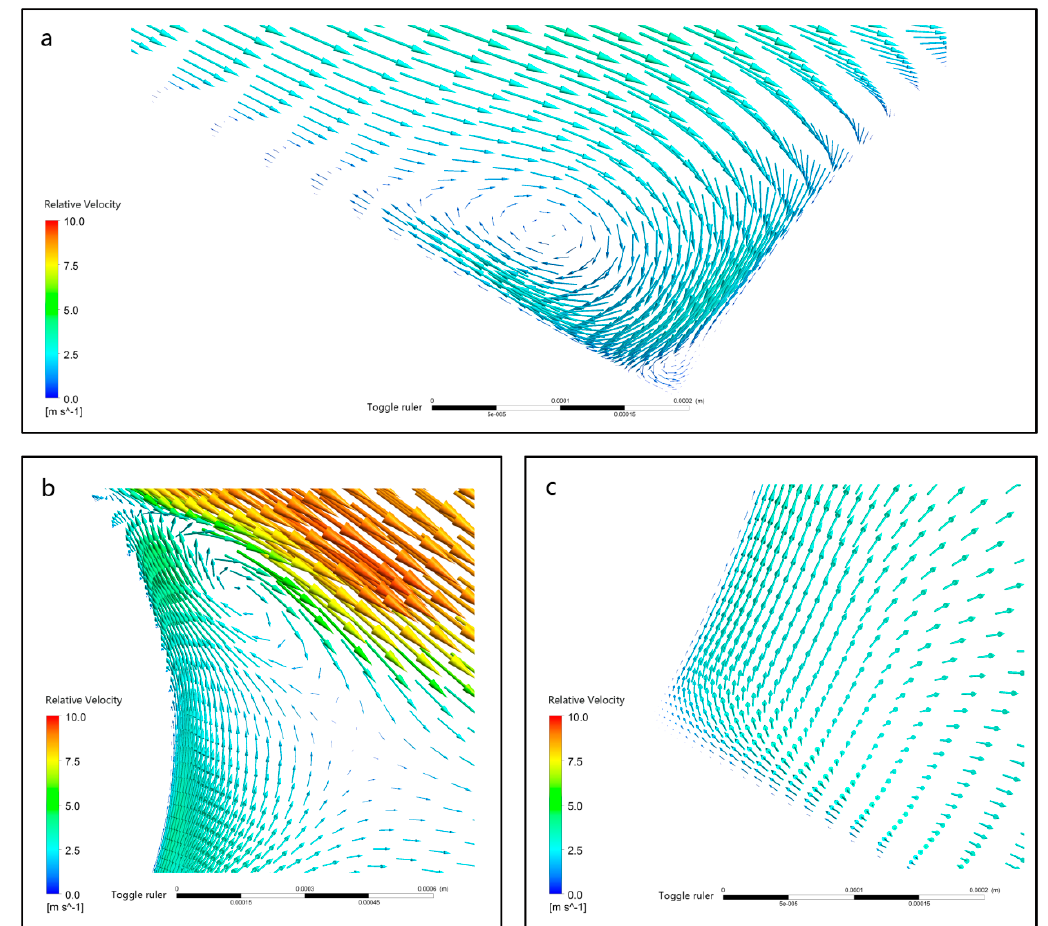
Figure 29. Detailed view of the flow around a bionic convex dome: ( a ) vortices near upstream surface; ( b ) vortex near separation point; ( c ) vortex near downstream surface.